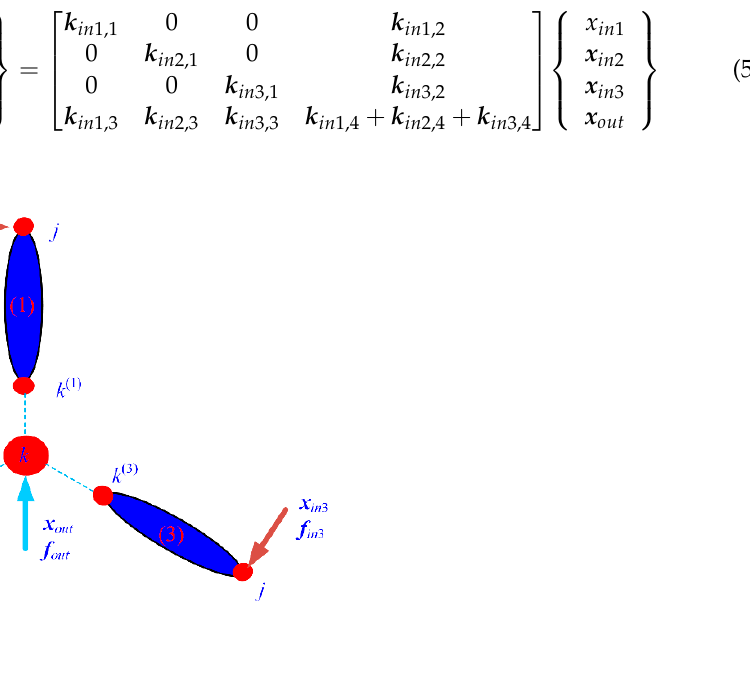
Figure 14. The equivalent topology of this platform.